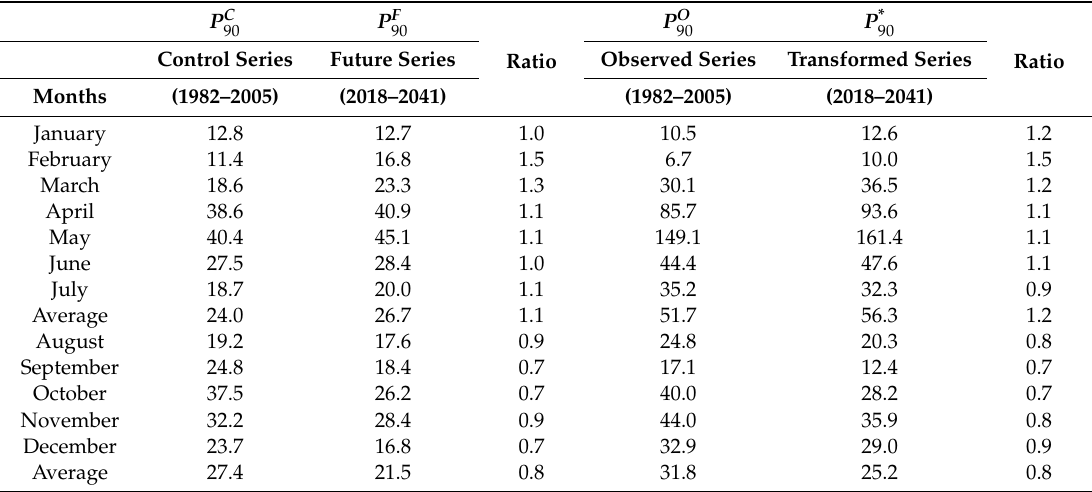
Table 7. Monthly summary of 90% quantiles and quantile ratios averaged for all